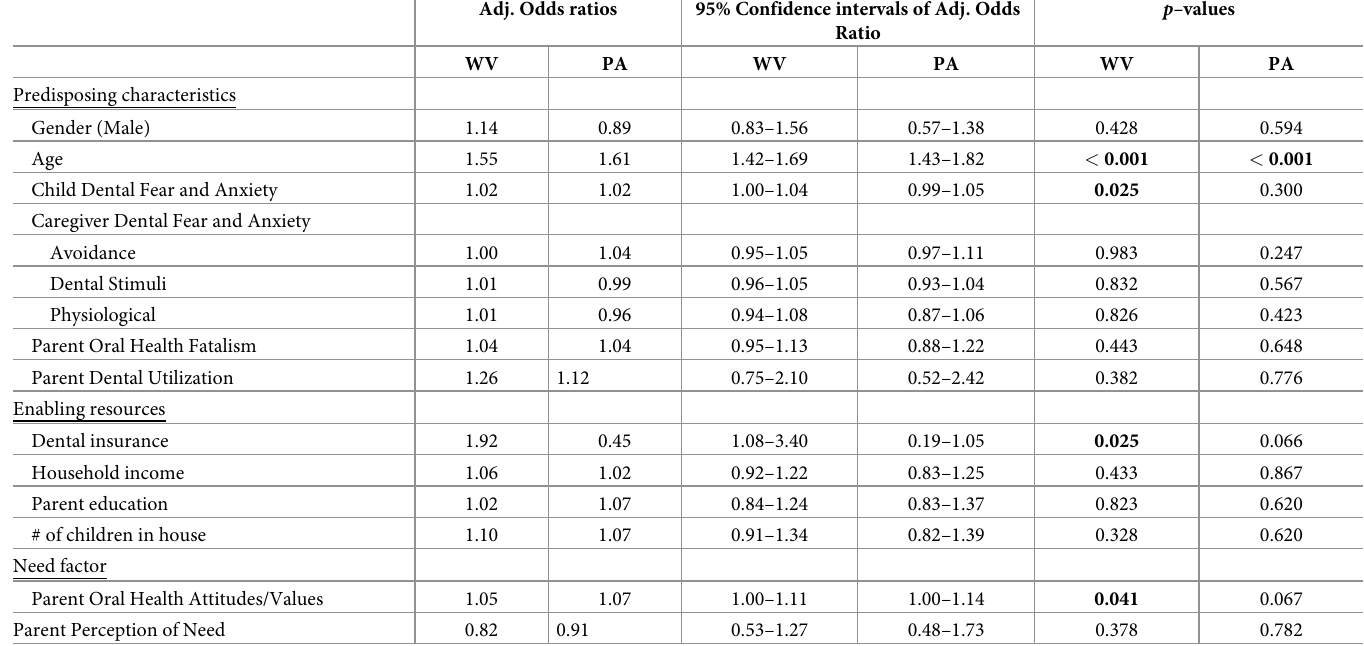
Table 3. State-stratified (WV [n = 767], PA [n = 411]) generalized estimating equation model results of dental utilization organized by the Andersen model factors; pooled imputed results reported. Adj. Odds